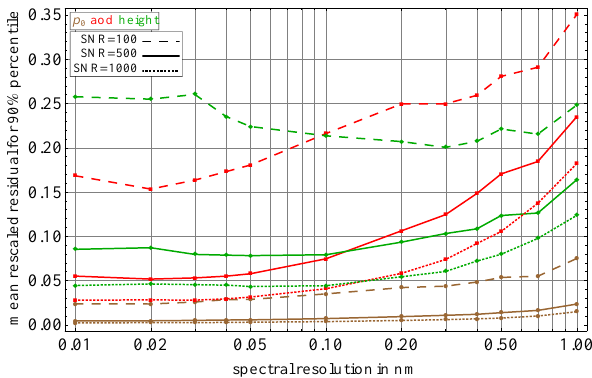
Figure 11. Inversion success of surface pressure (cyan), aerosol op- tical depth (red), and aerosol height (green) with respect to spec- tral resolution and prescribed signal to noise ratio (dashed, solid, dot dashed). Shown is the mean absolute residual of the 90% best inversion results in rescaled units (compare with Figs. 9 and 10). Spectral sampling for each point is equal to spectral resolution. The realistic case background settings were used.